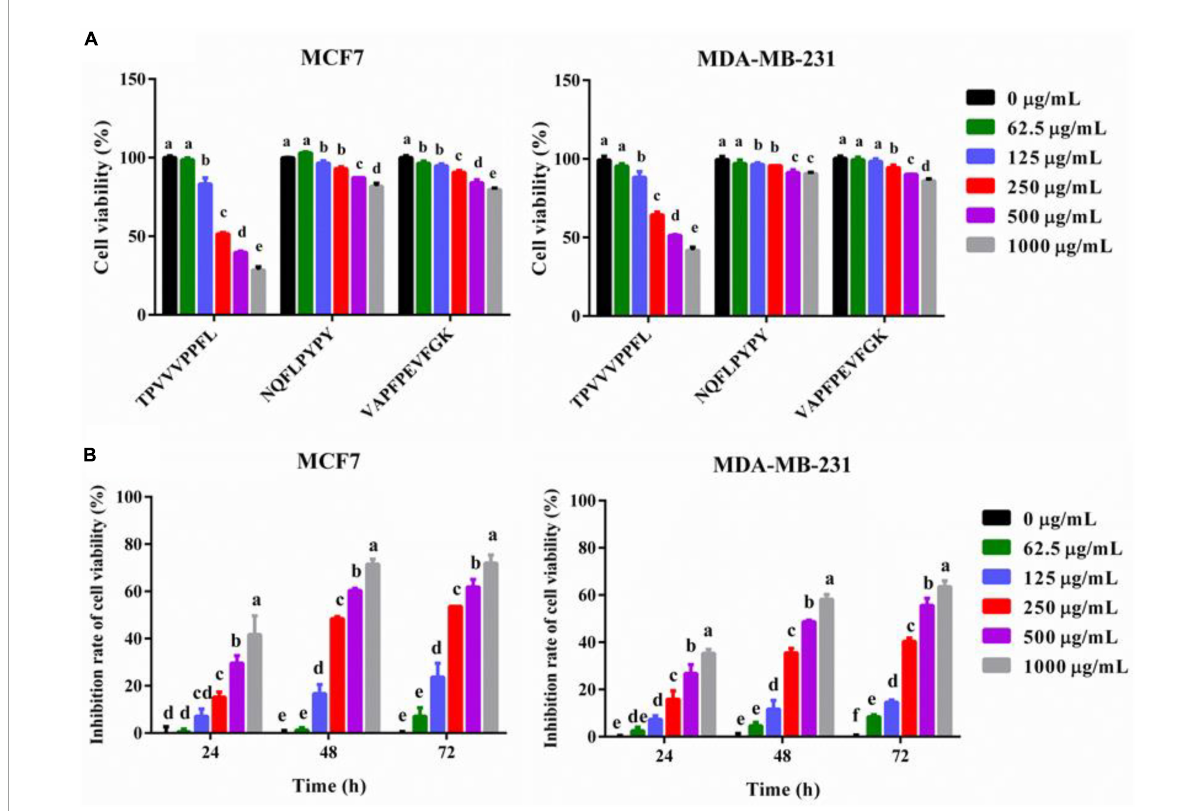
FIGURE5 Synthesized peptides inhibited the cell viabilities of MCF7 and MDA-MB-231 cells. (A) The effect of synthesized peptides on the cell viabilities of the two cells. Both malignant cells were treated with synthesized peptides (TPVVVPPFL, NQFLPYPY, and VAPFPEVFGK) for 48 h at the concentration of 0, 62.5, 125, 250, 500, and 1,000 ◦ µ g/mL. The cell viabilities were evaluated by CCK8. (B) The cell viability inhibition rate of TPVVVPPFL against MCF7 and MDA-MB-231 cells. The two malignant cells were incubated with TPVVVPPFL for 24–72 h at the concentration of 0, 62.5, 125, 250, 500, 1,000 ◦ µ g/mL, respectively. The inhibitory effects of TPVVVPPFL on both breast cancer cells were evaluated by